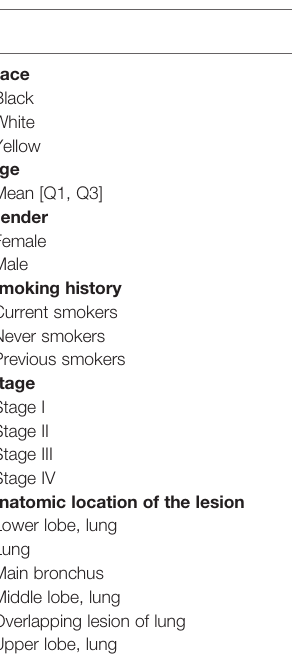
TABLE 1 | Clinical features of the LUAD